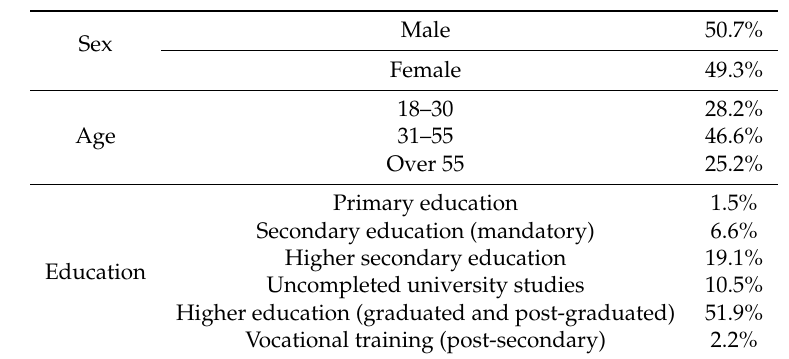
Table 2. Characteristics of the